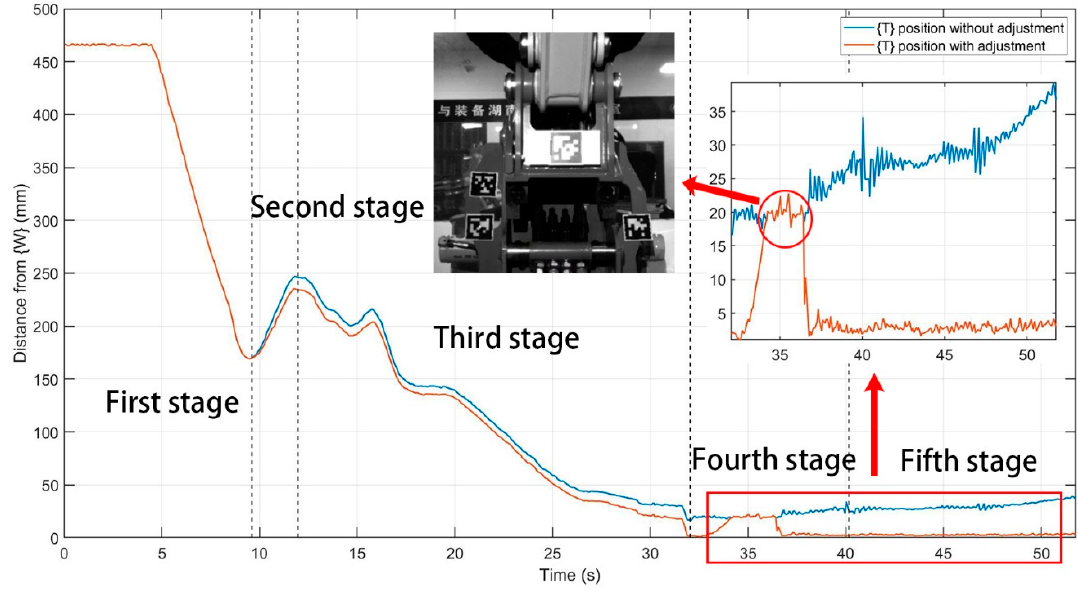
Figure 10. Error analysis of the experiment.